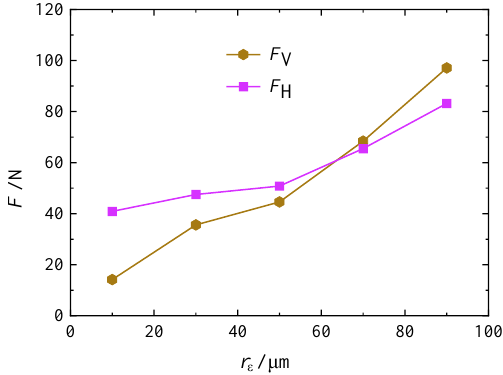
Figure 5. Cutting force at different rounded edge radii.